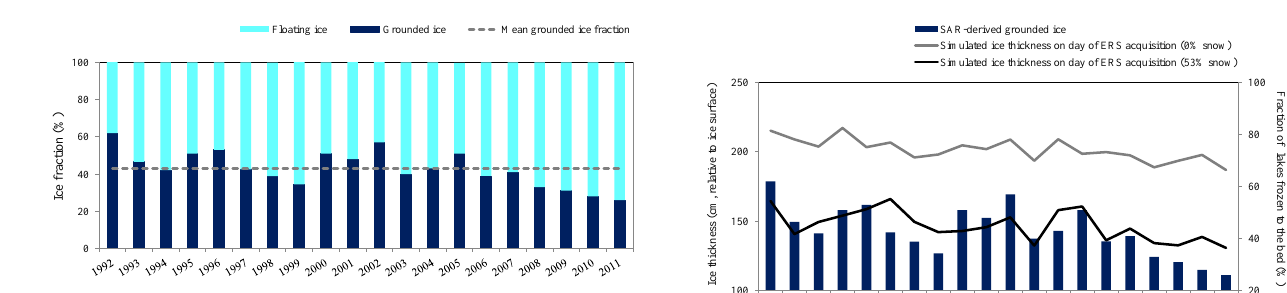
Fig. 5. Late winter (April/May) floating and grounded ice fractions Figure 5. Late winter (April/May) floating and grounded ice fractions from 1992 to 2011 from 1992 to 2011 resulting from segmentation of ERS-1 / 2 images. resulting from segmentation of ERS-1/2 images. 800